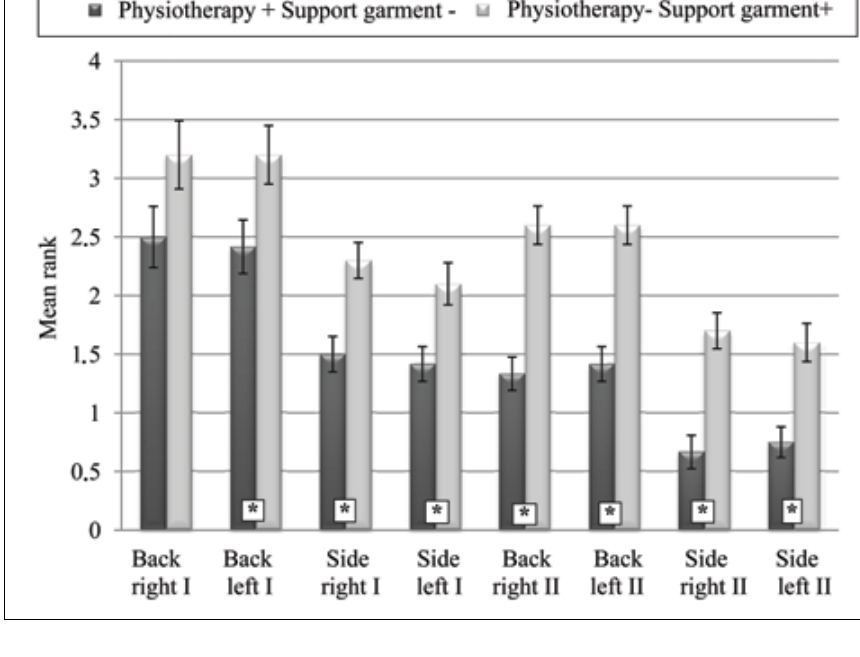
Figure 3. Activity of rectus abdominis muscles depending on presence (+) or absence (–) of physiotherapy and maternity support garment after delivery: abdominal